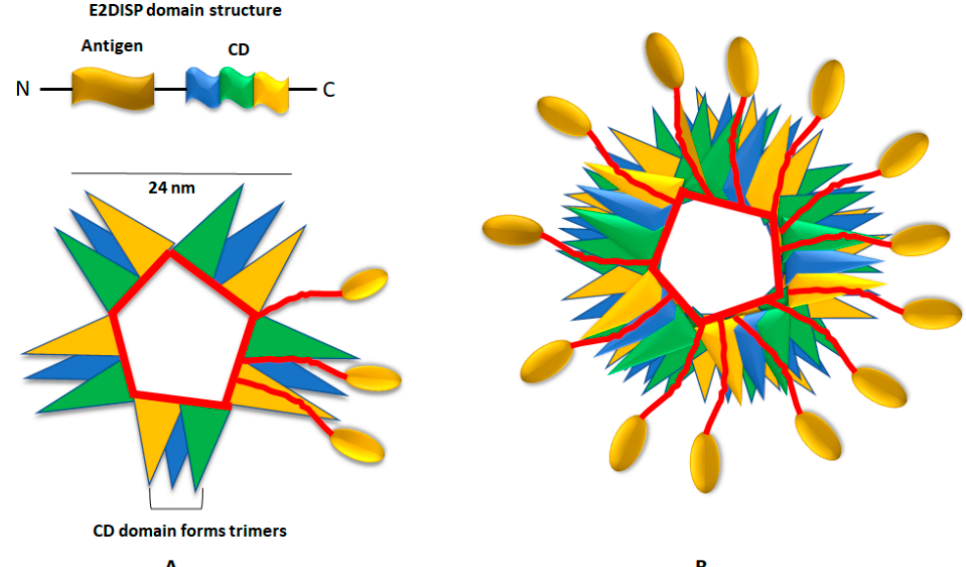
Figure 6. Illustration of the structure of E2 acetyltransferase display system (E2DISP) domain. ( A ) Representation of five catalytic acetyltransferase core domain (CD) trimers (monomers of each trimer is represented by blue, green and yellow colours). The C-terminal CD of E2 can self-assemble into trimers which aggregate to generate a pentagonal dodecahedral protein scaffold (see B). ( B ) Twenty trimers of the E2 polypeptide chain form a pentagonal dodecahedron (60-mer) with icosahedral symmetry. About 60 large polypeptides can be presented on the E2 scaffold as N-terminal fusions to the acetyltransferase CD. These particles can self-assemble in vitro and elicit T-cell and B-cell responses.